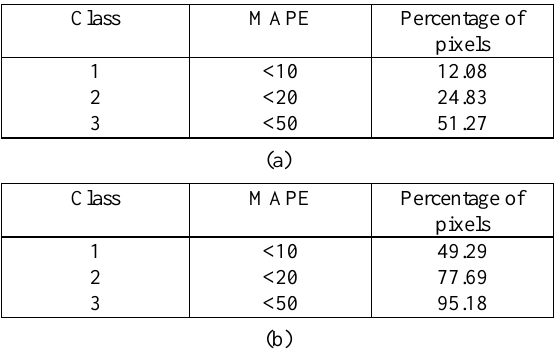
Table 2. The percentage of presence of pixels based on the absolute average percentage of error in Fars province